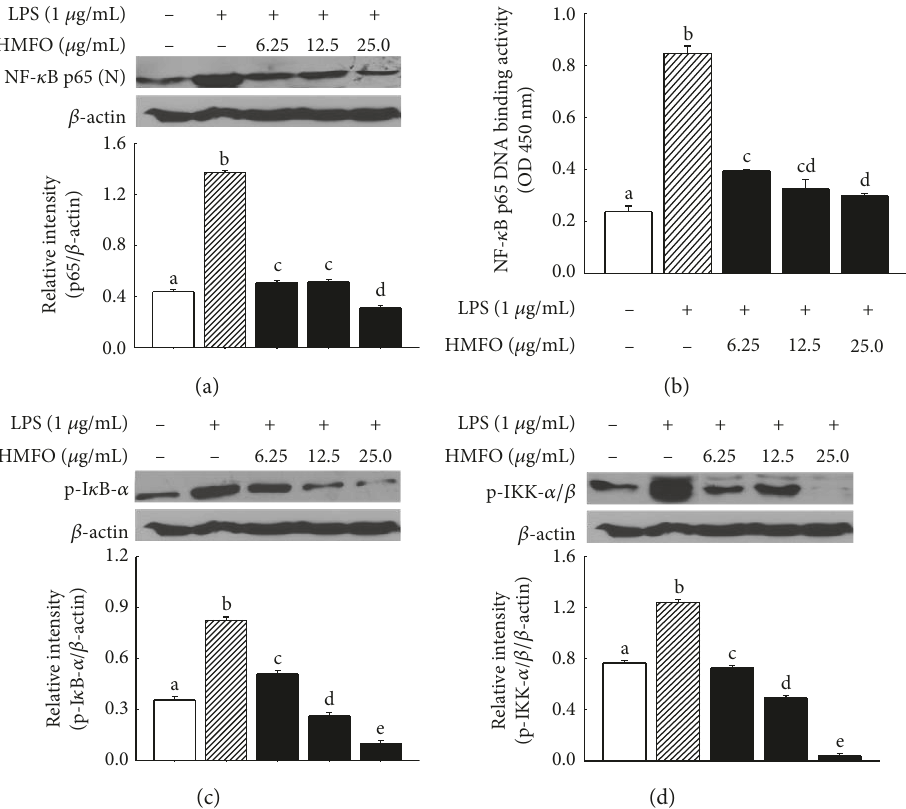
Figure 7: E ff ects of HMFO on the NF- κ B signaling pathways in LPS-induced RAW 264.7 macrophages. RAW 264.7 macrophages were pretreated with di ff erent concentrations of HMFO for 2 h and then stimulated with LPS for 22h. Phosphorylation of (a) p65, (b) I κ B- α , and (c) IKK α / β was analyzed by Western blotting. The NF- κ B DNA binding activies (b) were measured by NF- κ B (p65) transcription factor assay kit as described in Materials and Methods. Values with di ff erent letters are signi fi cantly di ff erent ( p < 0 05